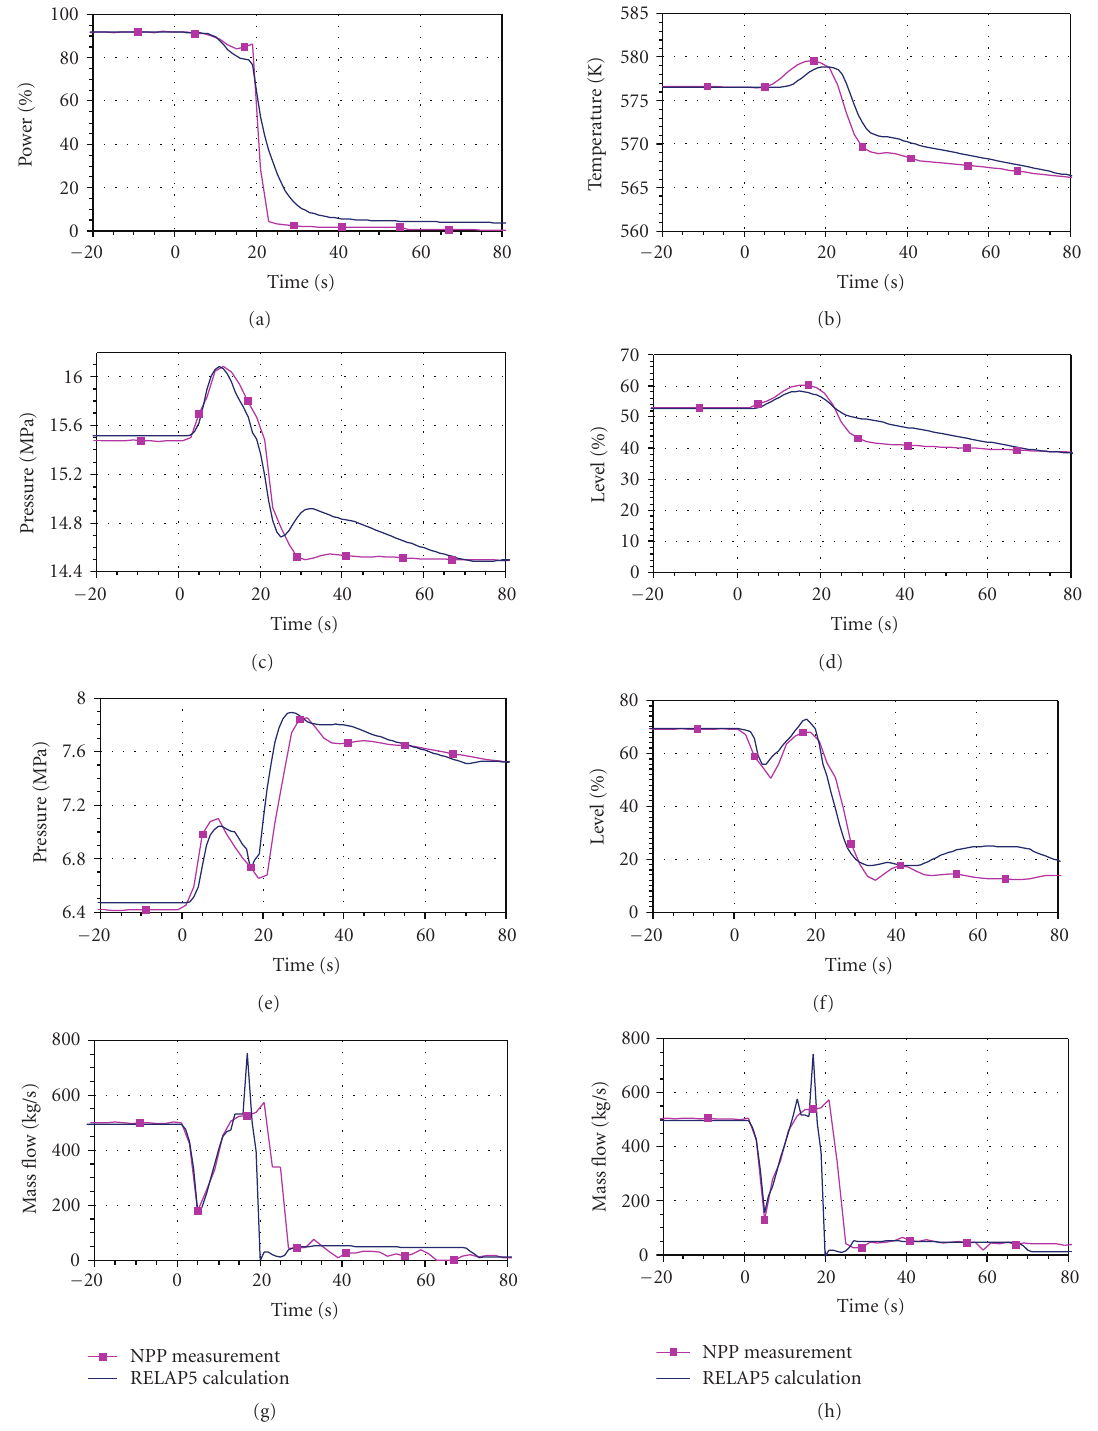
Figure 3: Transient with reactor trip—short term: (a) core power, (b) RCS average temperature, (c) PRZ pressure, (d) PRZ level, (e) SG 1 pressure, (f) SG 1 NR level, (g) SG1 steam flow, (h) SG 2 steam flow.